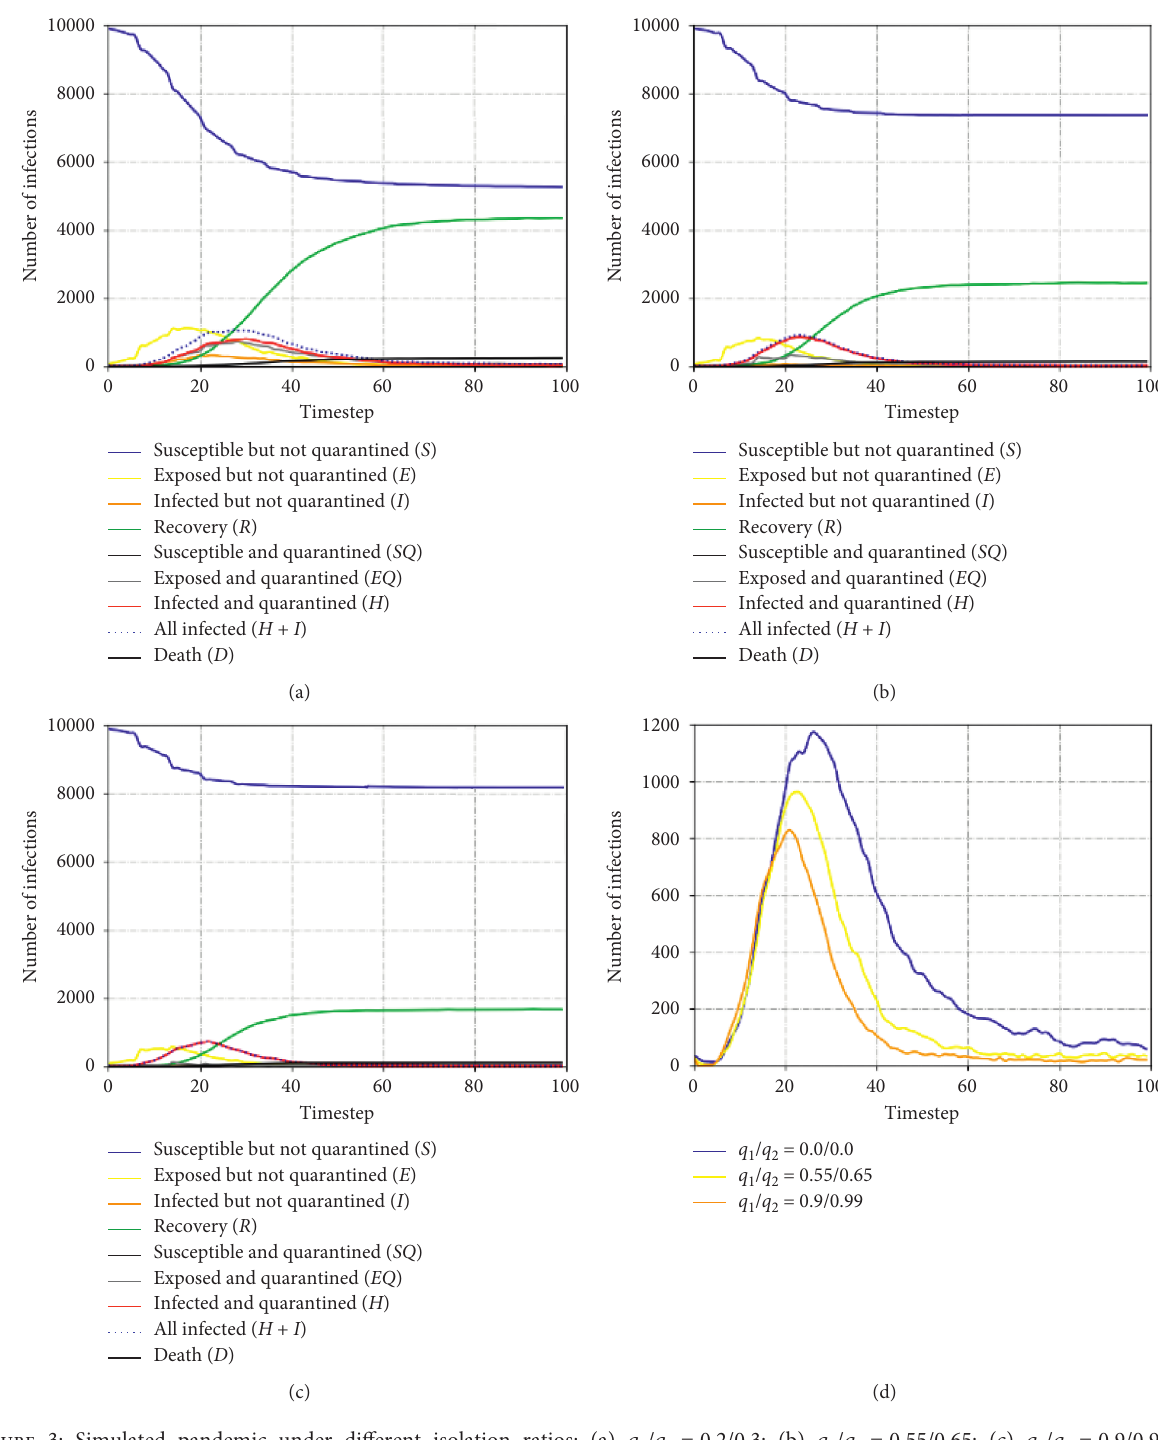
� 0 . 2/0 . 3; (b) q / q 1 2